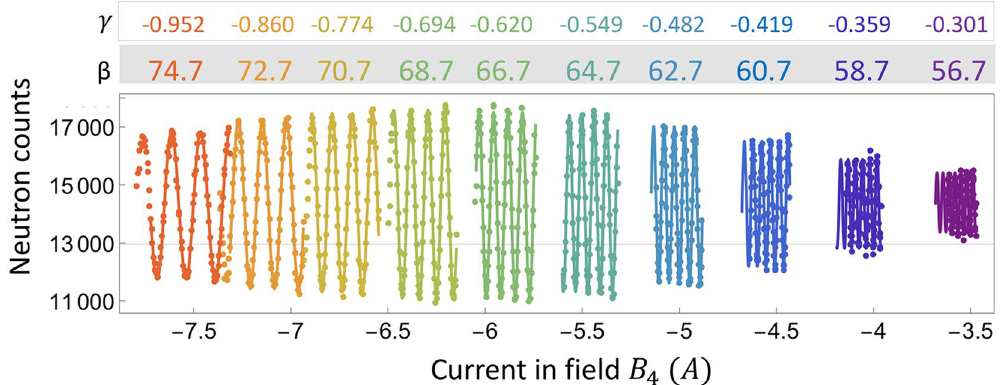
Figure 3. Intensities measured for the Si (111) diffraction for different ratios γ in single-arm configuration, where the fringes are obtained by scanning the current in B 4 and B 5 simultaneously. Different colors have different ratios between B 4 and B 5 , and the effective tilting angles they correspond to are given on the top of the picture, along with γ , the ratio between B 4 and B 5 . The difference between B 4 and B 5 is kept to be the same to avoid the effect of Larmor phase aberrations decreasing the fringe visibility. Beam size used for this tuning is 10 × 10 mm 2 .